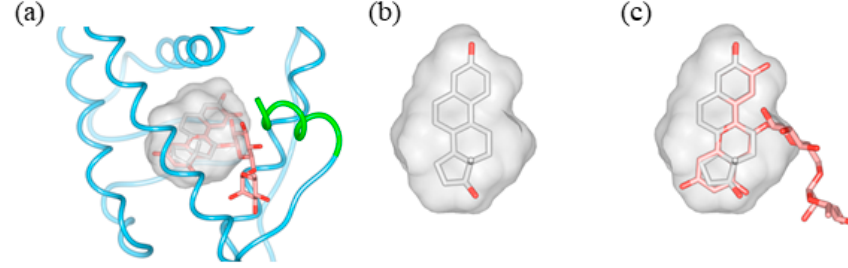
Figure 6. Interaction between the ligand-binding pocket of the ER β and 17 β -estradiol (E2) complex (PDB ID: 3OLS) and the sugar chain of cyanidin-3-rutinoside (C3R). ( a ) Docking model of C3R (light red) to the ER β and estradiol complex (gray); ( b ) Surface shape of the binding site and appearance of E2; ( c ) Overlapping E2 and C3R; the sugar chain of C3R does not fit.